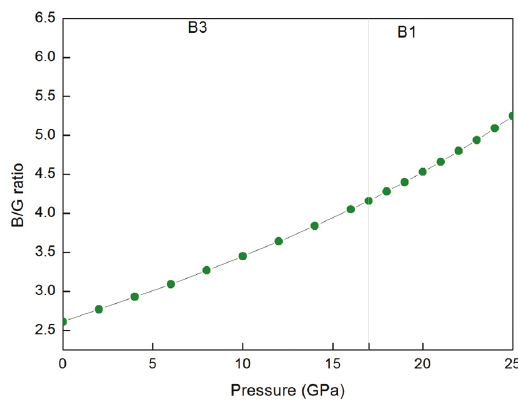
Figure 5. B/G ratio versus pressure for GaAs.